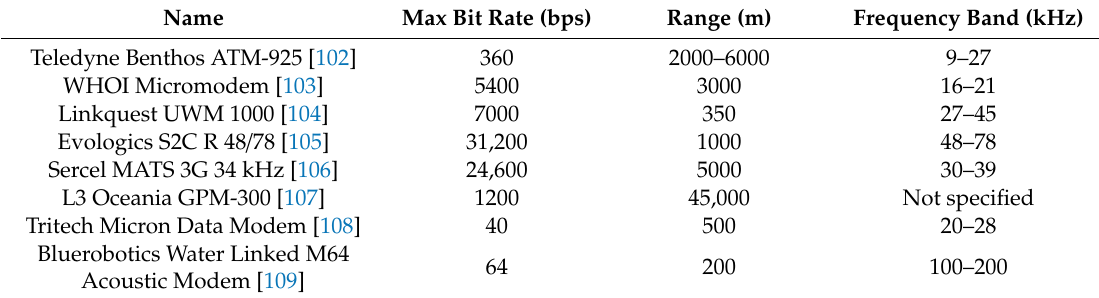
Table 5. Commercial acoustic